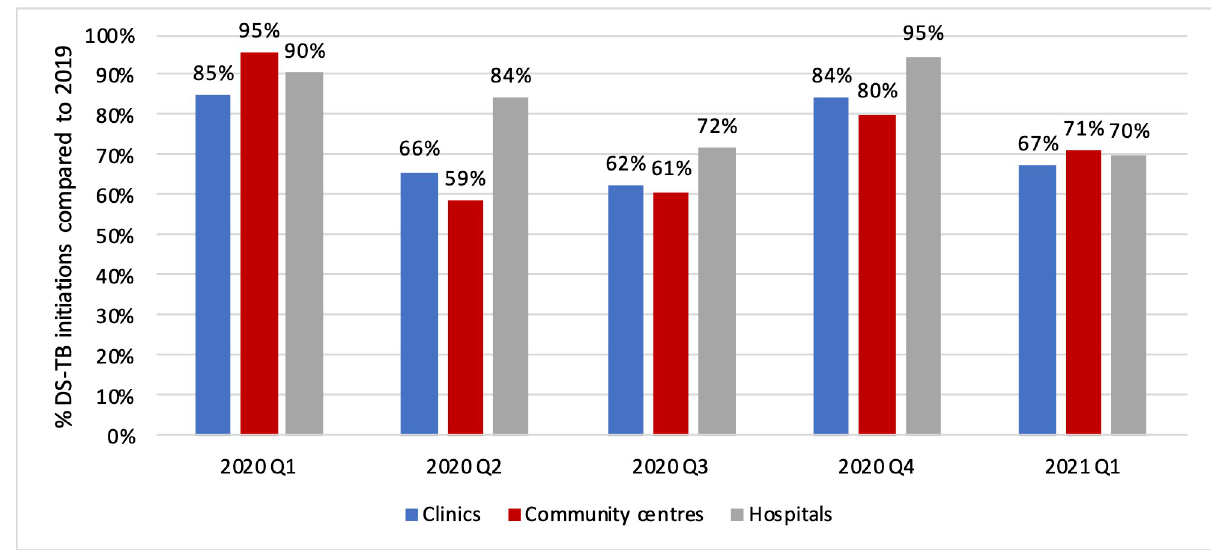
Fig 3. Drug sensitive TB initiations as proportion of initiations in the same quarter of 2019, by facility level.